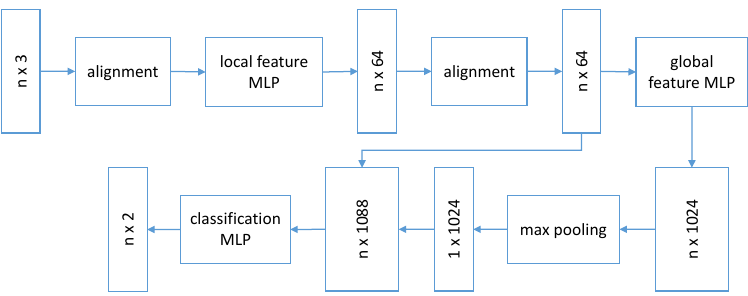
Figure 1: PointNet architecture. MLP stands for multi layer perceptron.Alignment blocks are